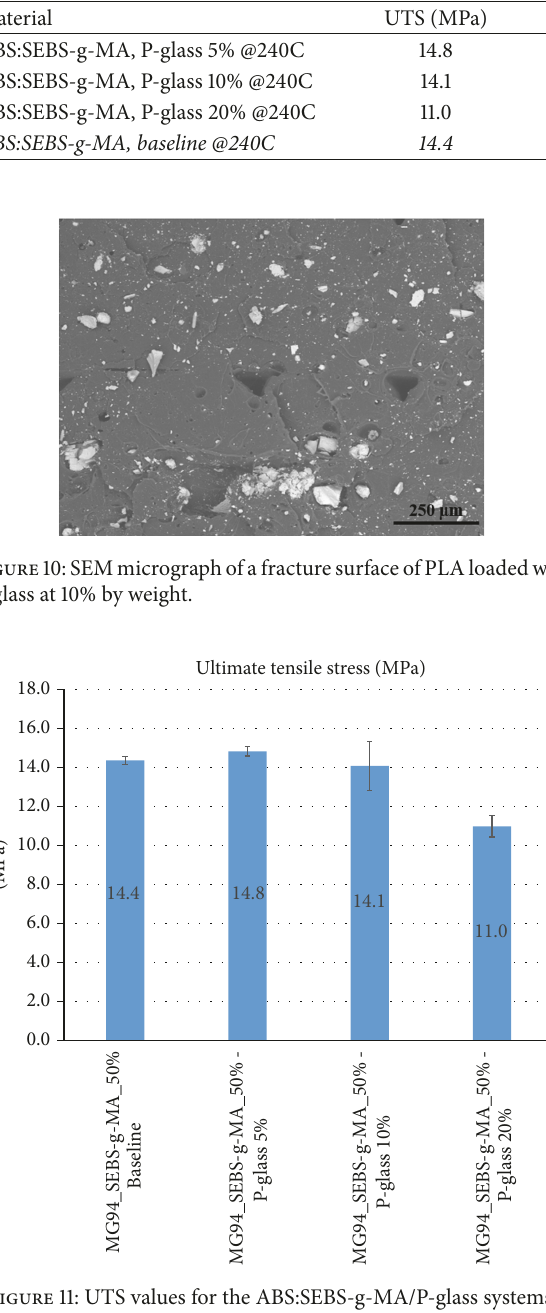
from 54 ± 14 % for the baseline specimens to 69% ± 4%. The only system which exhibited a reduction of % EL at break as compared to baseline ABS:SEBS-g-MA specimens was the 10% P-glass loading printed at 240 ∘ C. The reduction of percent elongation at break for this system occurred because of large P-glass agglomerates that acted as crack initiation sites as determined by the fractographic analysis in Figure 14 indicated by circles, where the longitude of middle right particle is around 34.5 𝜇 m and bottom left 22.5 microns.